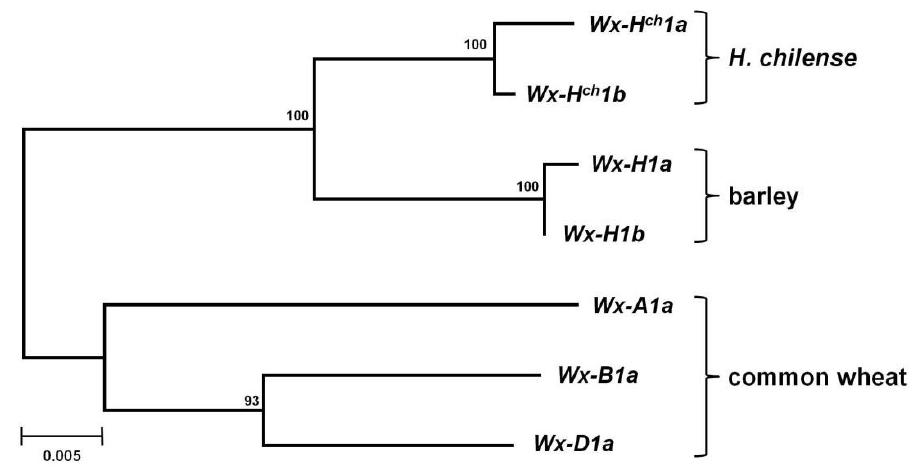
Figure 4. Neighbor-joining tree based on the Poisson correction method for amino acid sequences analyzed. Number above nodes indicates bootstrap estimates from 1000 replications.